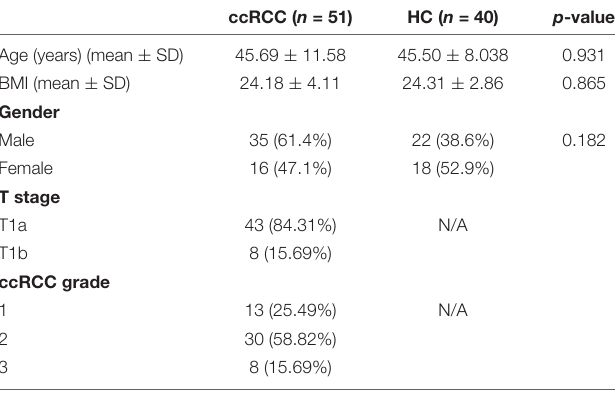
TABLE 1 | Clinical characteristics of ccRCC patients and healthy